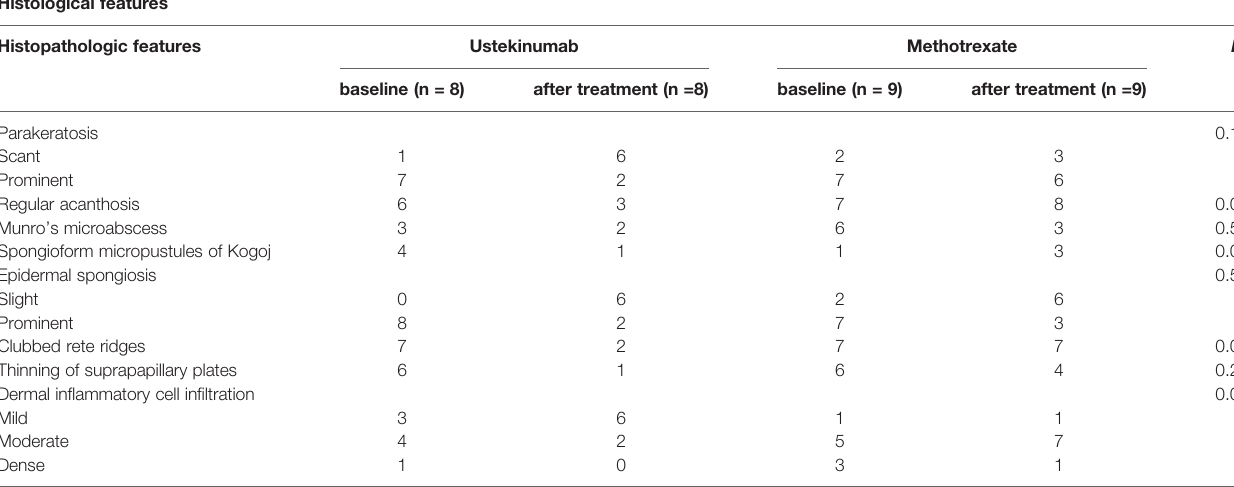
TABLE 2 | Histopathologic features of ustekinumab- (biologics) and methotrexate-treated psoriasis (oral medication) patients. Histological